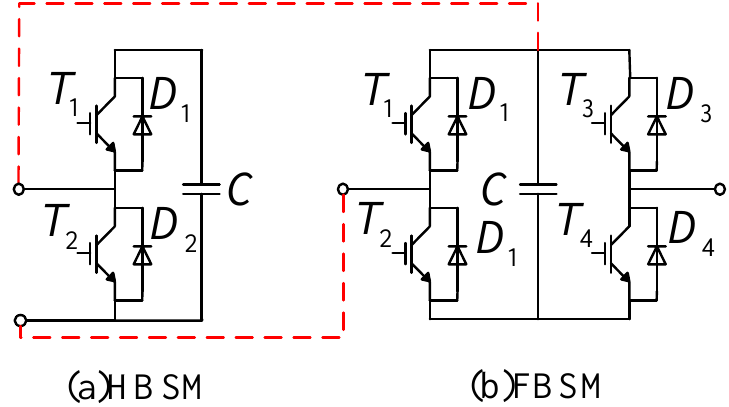
Figure 1. CHBFBSM combination diagram: ( a ) HBSM; ( b ) FBSM.